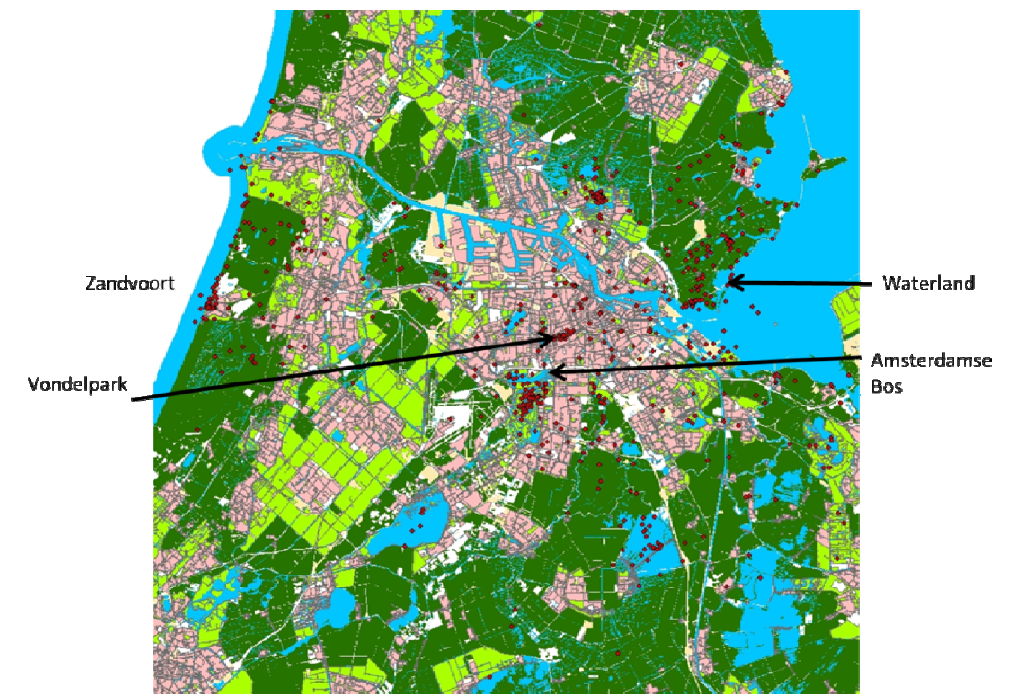
Figure 4. The city of Amsterdam with markers indicating the regional favourite natural places of Amsterdam residents (n = 652).